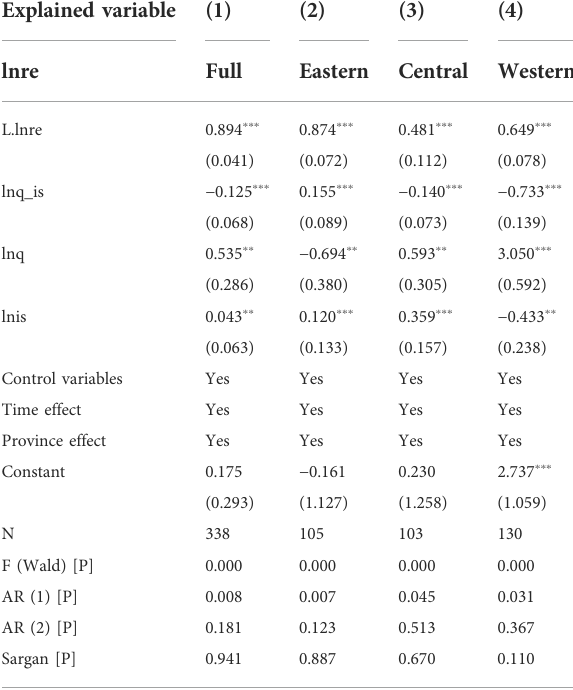
TABLE 3 Estimated results of the industrial structure in fl uences (1). Explained